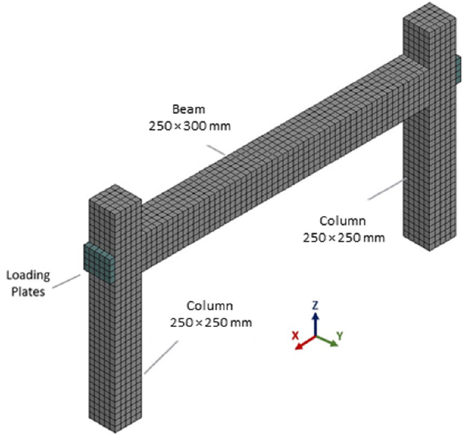
Figure 4. General layout of initial model in LS-DYNA.